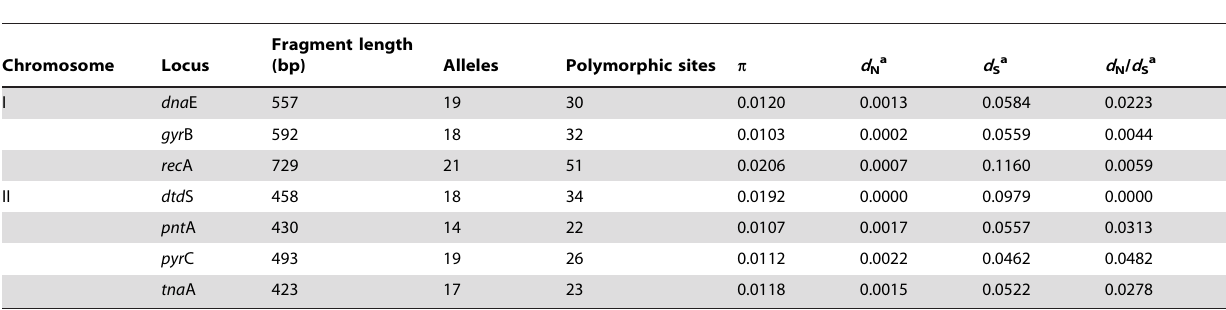
Table 1. Summary of loci statistics included in the MLST scheme ( dna E, gyr B, rec A, dtd S, pnt A, pry C and tna A) such as fragment length, number of alleles and polymorphic sites, nucleotide diversity ( p ), rates of nonsynonymous ( d N ) and synonymous ( d S ) mutations, and tests of selection ( d N / d S